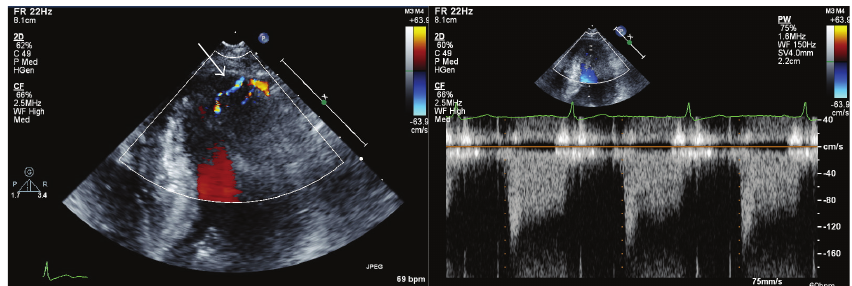
Figure 4: Doppler echocardiography. Color signal visible through the multiple coronary artery fistulas, which directly communicated with the left ventricle, as seen in the apical four-chamber view (left). Pulsed wave Doppler image confirming the diastolic flow of the coronary artery fistulas